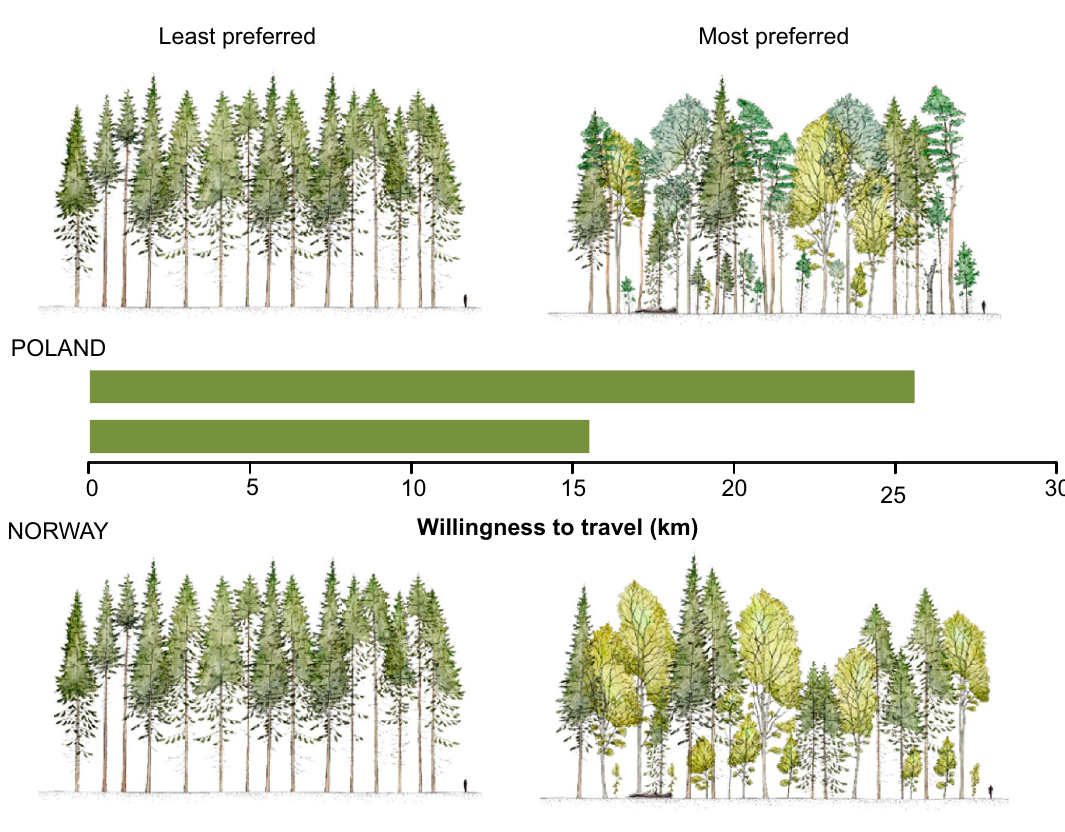
Figure 2. Visual representation of the least and most preferred forest structure by respondents in Poland (N = 1097) and Norway (N = 1005), expressed as willingness-to-travel (kms). The least preferred forest structure in both countries was young (40 years) even-aged coniferous monoculture without dead wood. As the age of the stand had a strong effect on the willingness-to-travel, to better reflect the differences in preferences for forest structures, the figure shows the least and most preferred forest of the same